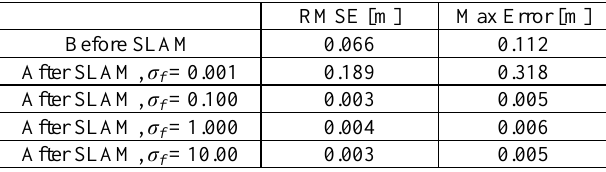
Table 1: Error in estimated trajectory for various σ f 3.1.2